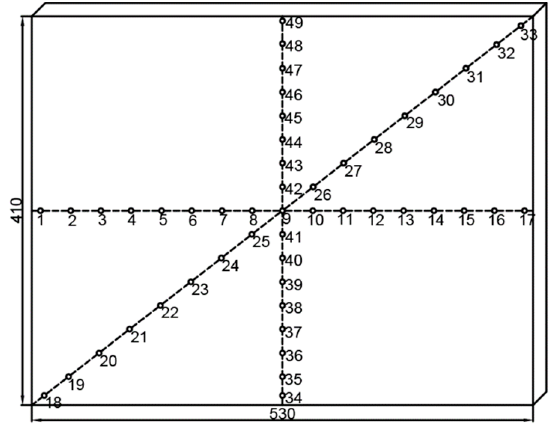
Figure 12. Section sampling illustration for carbon segregation determination.